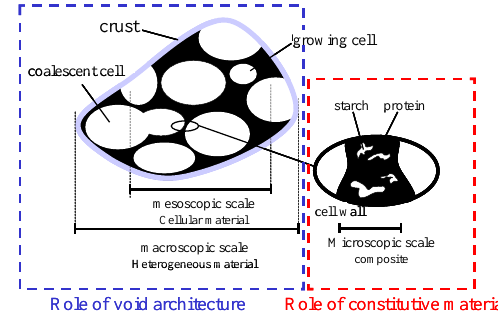
Fig. 1. Biopolymer cellular material within the multiscale approach (Example of the bread